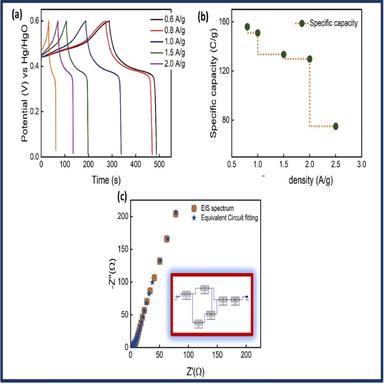
(a) GCD plot of Cu-BTC-MI MOF (b) Qs trend with current density (c) EIS spectrum of Cu-BTC-MI MOF electrode.